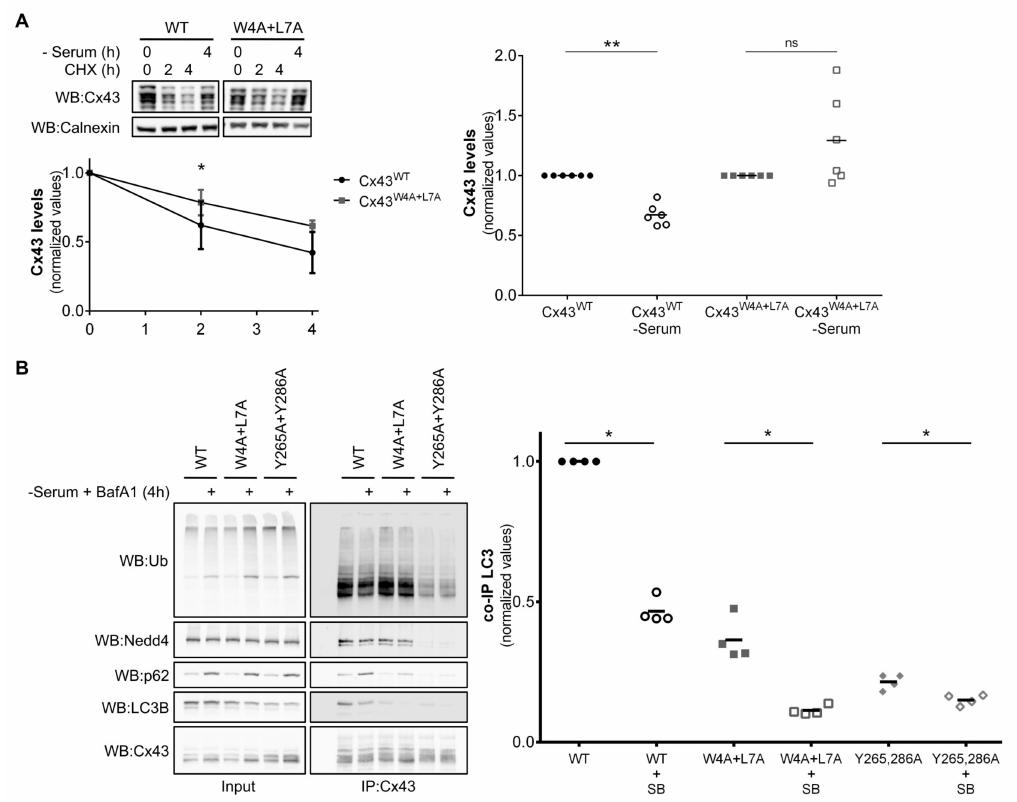
Figure 7. Mutation of the LIR motif of Cx43 renders the protein resistant to nutrient deprivation induced autophagic degradation. ( A ) HEK293A cells transfected with either wild type (WT) or mutant Cx43 (W4A + L7A) were either incubated with 50 µ g / mL cycloheximide (CHX) for 2 or 4 h or subjected to starvation with media without serum for 4 h. Lysates were analysed using Western blot using goat polyclonal antibodies against Cx43 and calnexin. Cx43 levels were quantified, normalized to calnexin and plotted in a graph. * p < 0.05 using the multiple Student’s t-test with Holm-Sidak’s correction. ( B ) HEK293A cells co-transfected with GFP-LC3B and either wild type (WT) or mutant Cx43 (W4A + L7A, Y265,286A) were incubated in media without serum supplemented with 50 µ M BafA1 for 4 h (SB). Cell lysates were then subjected to immunoprecipitation with goat polyclonal antibodies against Cx43, and the precipitates were analysed using Western blot using mouse monoclonal antibodies against ubiquitin and p62, or rabbit polyclonal antibodies against Cx43, Nedd4 and LC3B. The level of co-immunoprecipitated LC3B with connexin in each condition was quantified, normalized to the immunoprecipitated connexin and plotted in a graph. * p < 0.05 using the Mann-Whitney